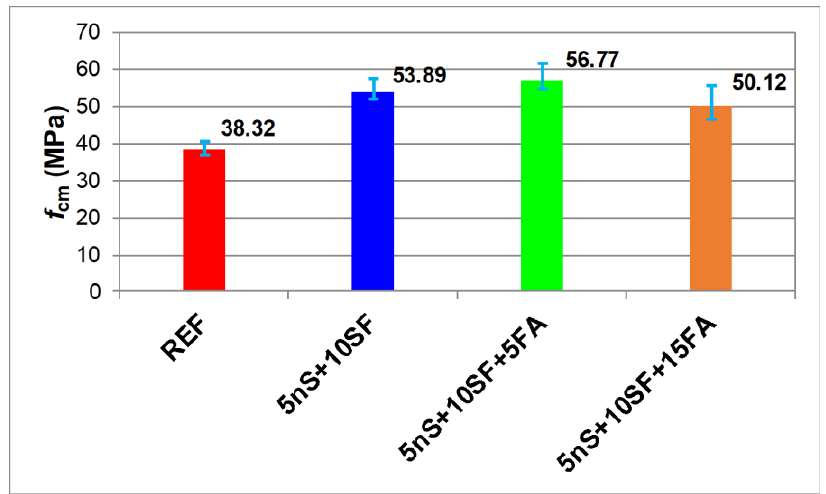
Figure 6. Results of compressive strength of concretes.